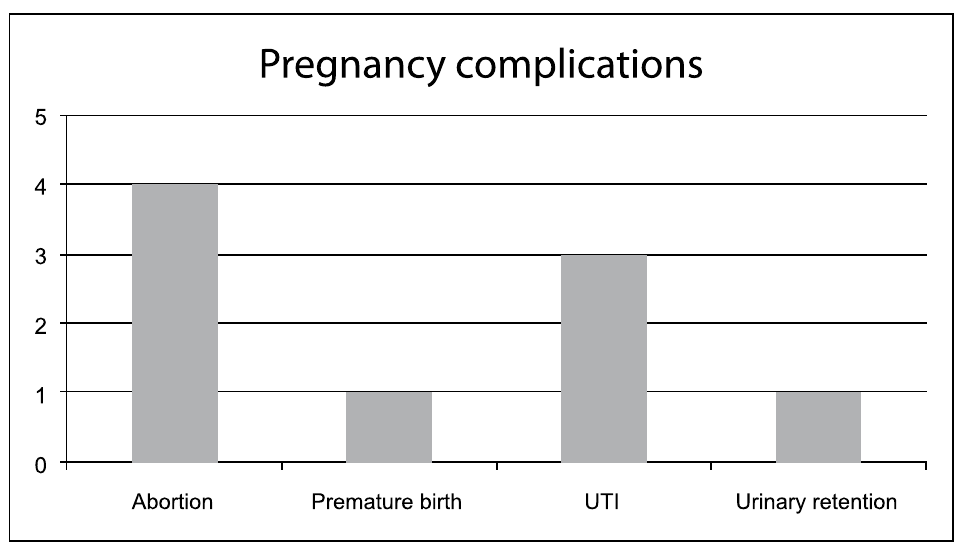
Figure 1 - Pregnancy complications regarding the 22 pregnancies assessed.